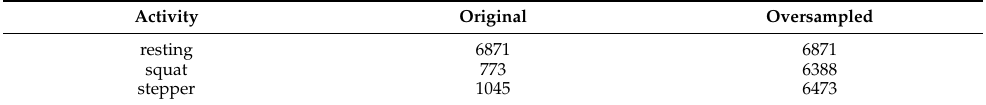
Table 2. Number of data windows for the 3 classes, limited to the first 5 subjects.